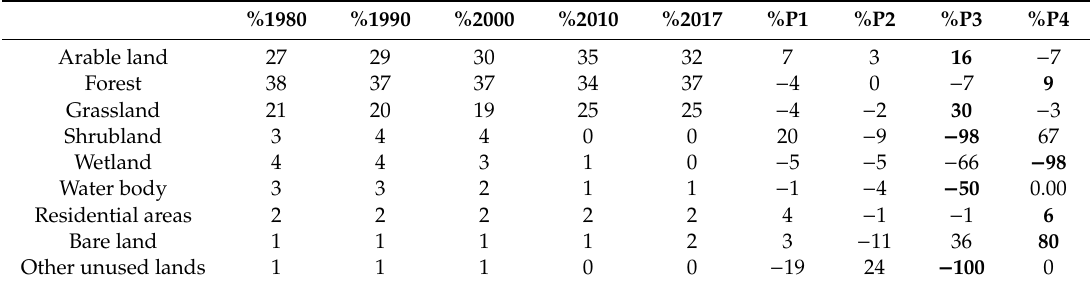
Area percentage of each land use class in 1980–2017 and their change rates (R = 100 × (Area i + 1 − Area i ) / Area i ; i represents the year used) in di ff erent time phases P1